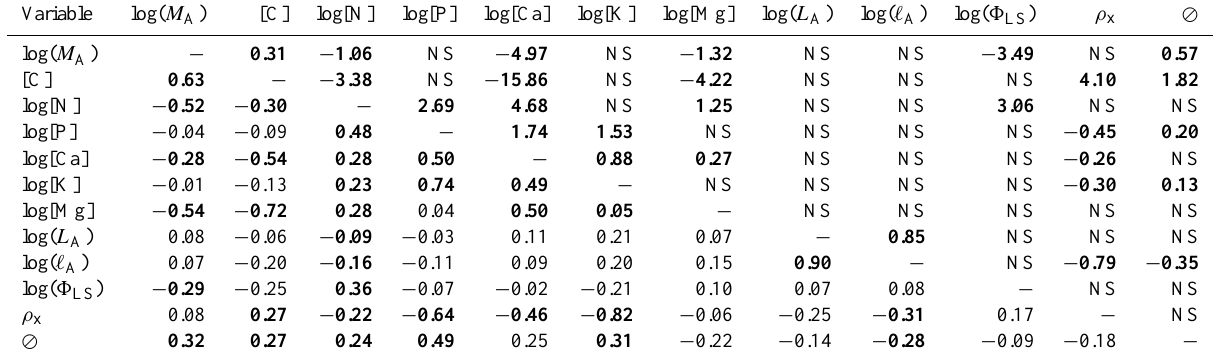
Table 3. Bivariate relationships for the derived environmental component of the observed plant traits.Values above the diagonal represent the slope of the relationship (y axis as columns labels, x axis as row labels). Values below the diagonal represent the correlation coefficient. Values significant at P < 0 . 05 are given in bold. NS = no slope estimated as the relationship was not significant. For units and symbols, see Table